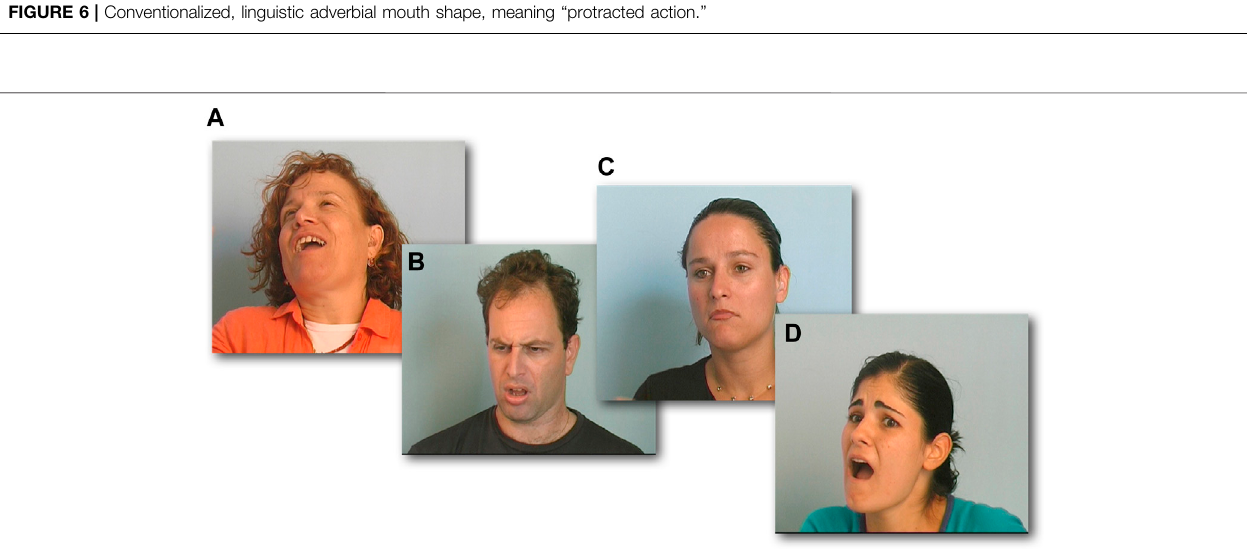
FIGURE 7 | Emotional facial gestures in ISL, in reaction to information that evokes: (A) happiness, (B) disappointment, (C) sorrow, (D)